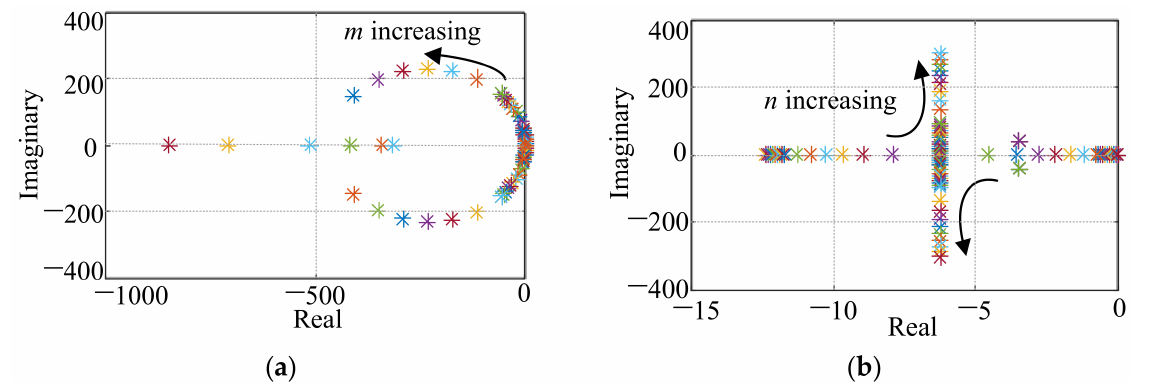
Figure 4. System dominant root locus at ( a ) m ∈ [1 × 10 − 6 , 1]; ( b ) n ∈ [1 × 10 − 6 , 1 × 10 − 1 ].